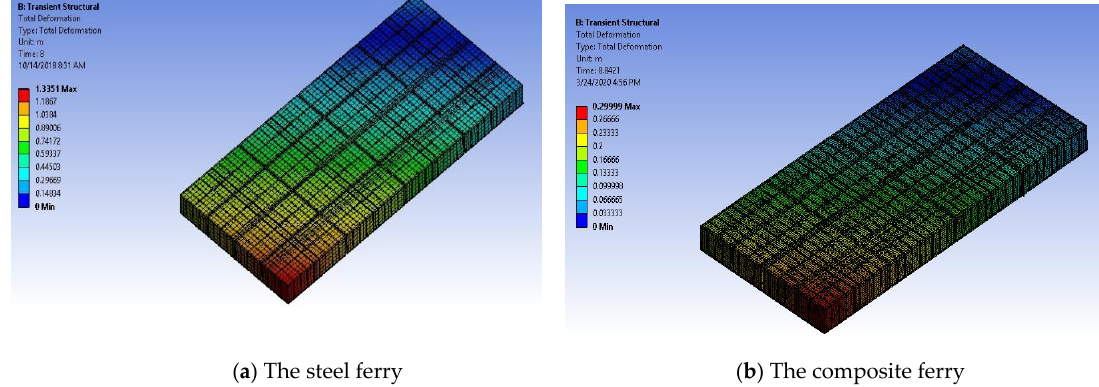
Figure 31. The total deformation distribution in case 4.